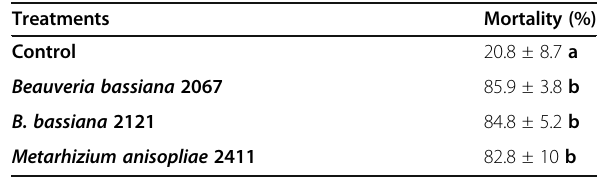
Table 1 Percentage of Diaphorina citri mortality